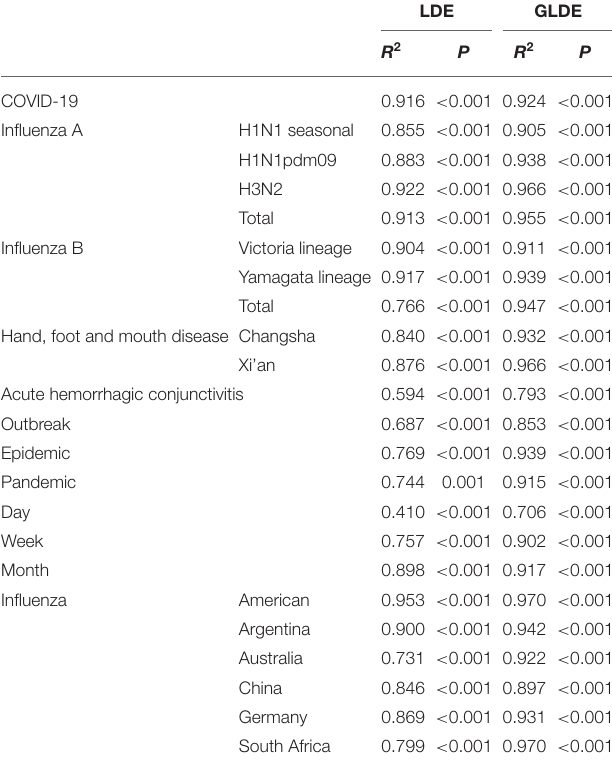
TABLE 3 | The results of